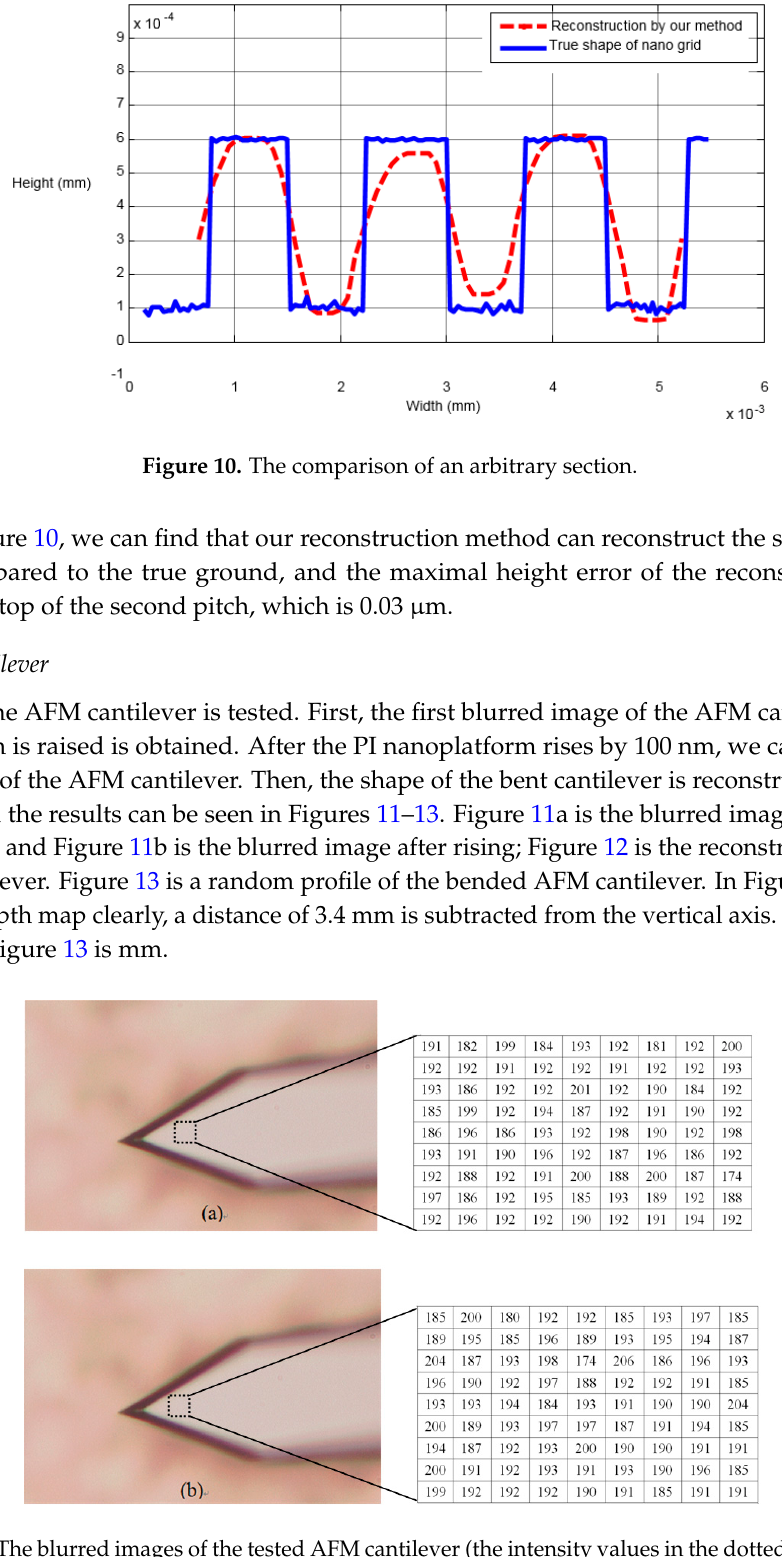
Figure 11. The blurred images of the tested AFM cantilever (the intensity values in the dotted rectangles are presented with two matrixes). ( a ) The blurred image before the platform is raised. ( b ) The blurred image after raising the platform.